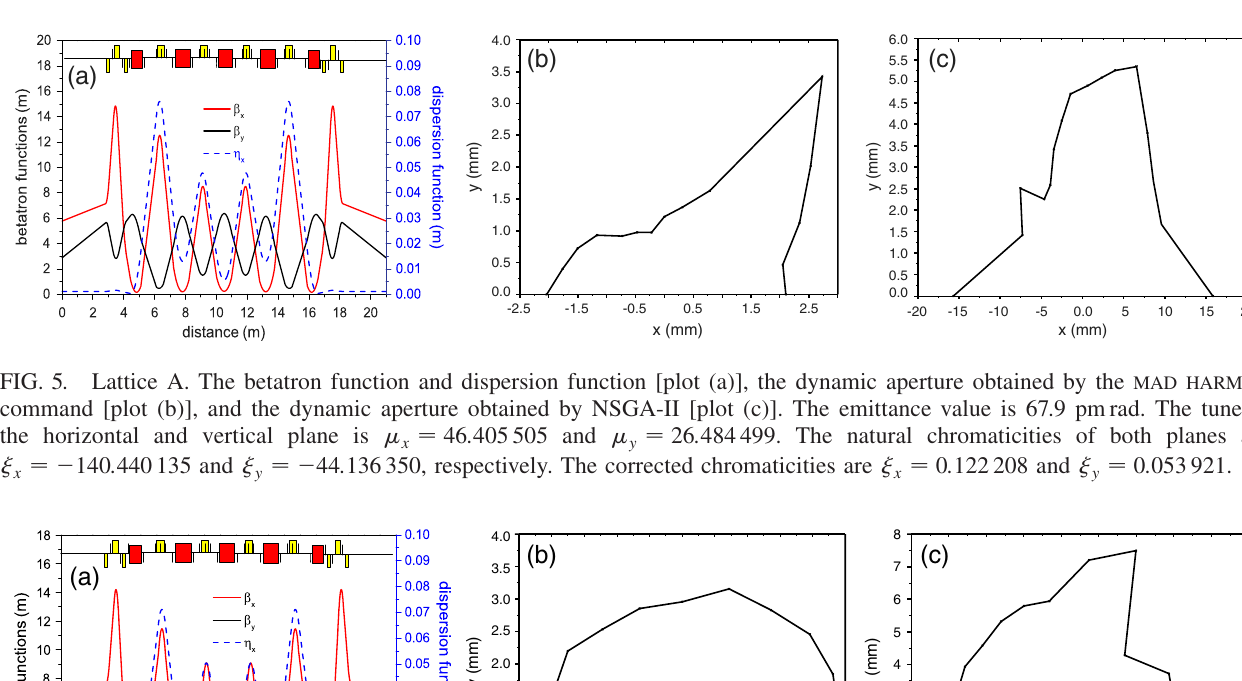
FIG. 6. Lattice B. The betatron function and dispersion function [plot (a)], the dynamic aperture obtained by the MAD HARMON command [plot (b)], and the dynamic aperture obtained by NSGA-II [plot (c)]. The emittance value is 64.1 pm rad. The tunes in the horizontal and vertical planes are (cid:6) x ¼ 46 : 112 960 and (cid:6) y ¼ 24 : 959 340 . The natural chromaticities of both planes are (cid:5) ¼ (cid:1) 134 : 567 099 and (cid:5) ¼ (cid:1) 45 : 589 299 , respectively. The corrected chromaticities are (cid:5) x y